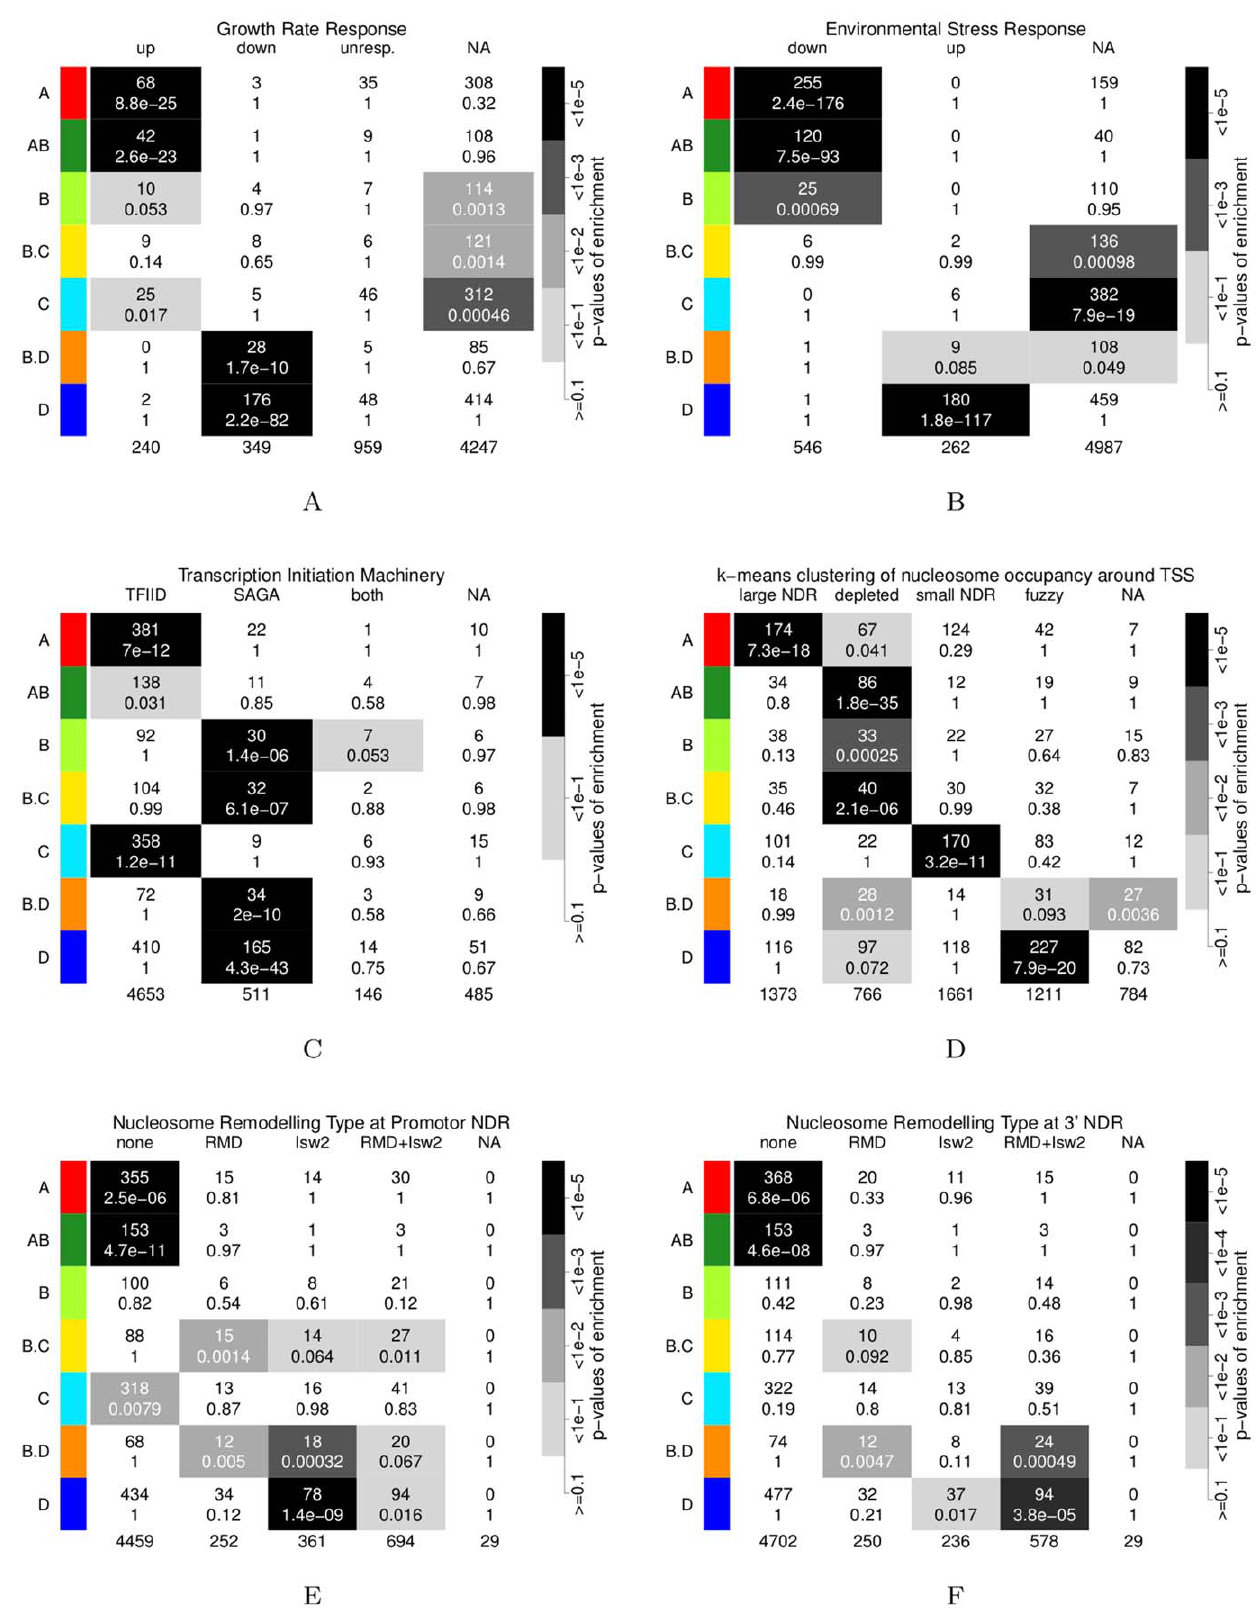
Figure 2. Overlap of the consensus clusters with other gene clusterings. Clusters were tested for enrichment in other gene categorizations by cumulative hypergeometric distribution tests. The text in the fields gives the number of genes in the respective overlap (top line) and the p-values